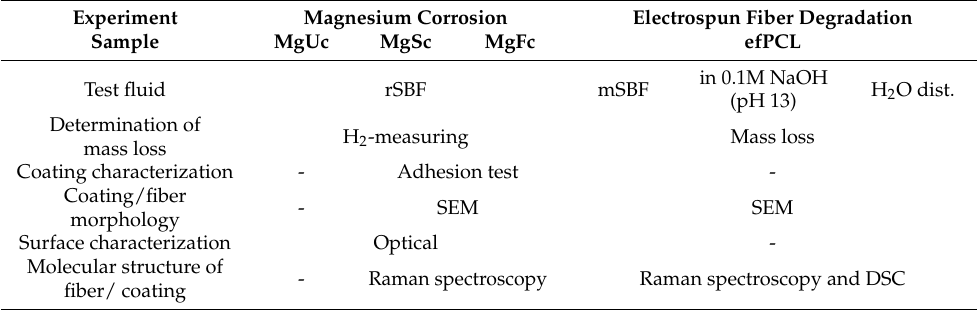
Table 2. Overview of experimental setups and analysis (MgUc: uncoated magnesium, MgSc: spin- coated magnesium, MgFc: electrospun fiber-coated magnesium, efPCL: electrospun fiber